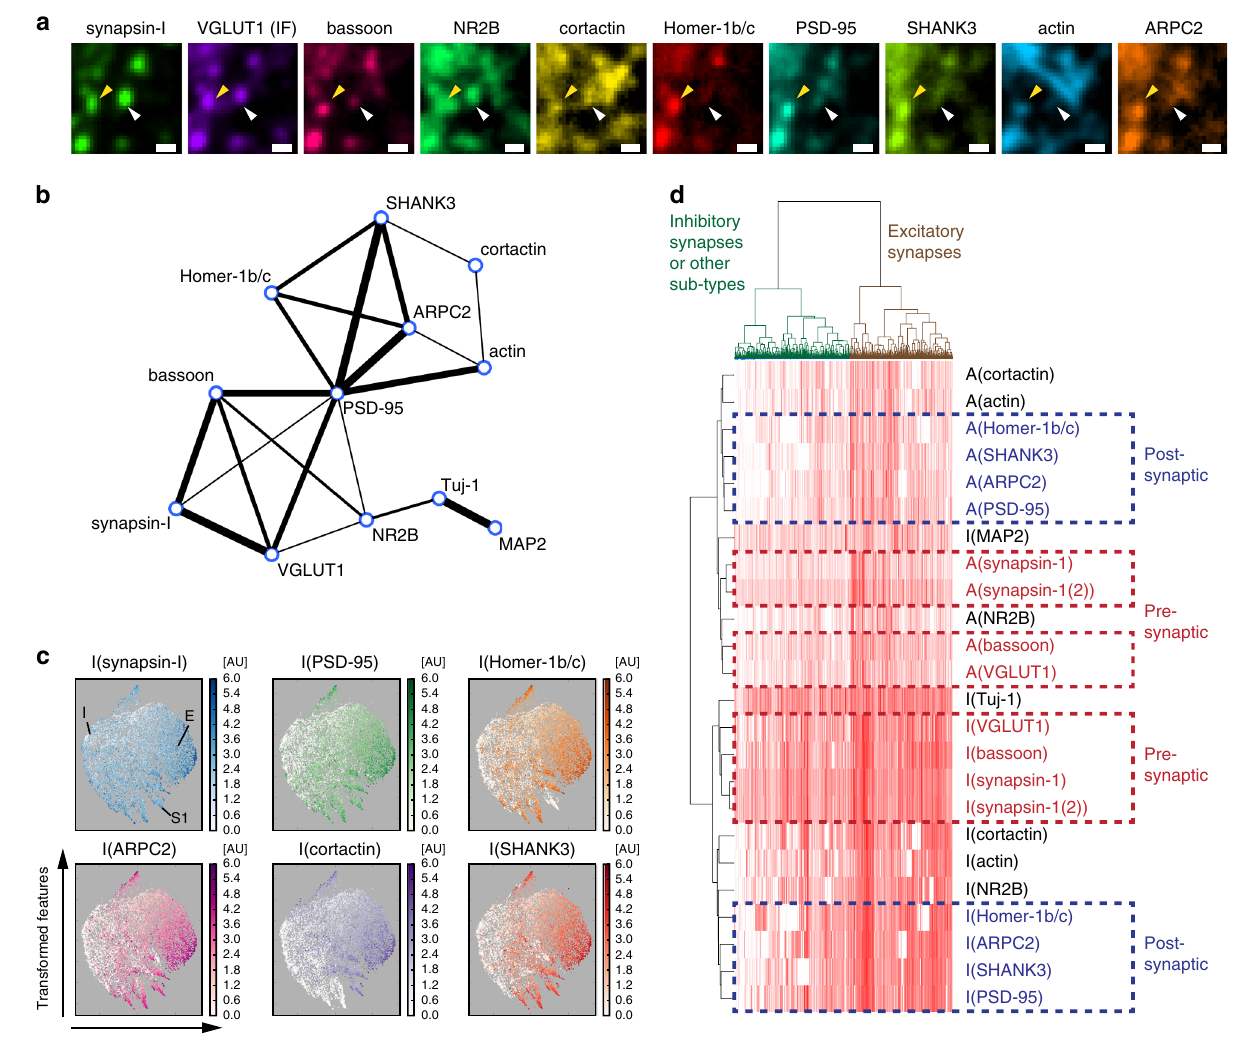
Fig. 4 Analysis of single-synapse pro fi les from confocal imaging. a LNA-PRISM images of a conventional excitatory synapse (yellow arrowhead) with co- localization of every synaptic marker measured, and a synapse with only a subset of markers present (white arrowhead). Scale bar: 1 μ m. b Network representation of correlations between intensity levels of synaptic proteins within synapses ( n = 178,528 synapses from three cell culture batches). The thickness of each edge represents the relative correlation strength between the respective nodes. c t-Distributed Stochastic Neighbor Embedding (t-SNE) plots of n = 10,000 synapses from a single culture batch; each with 20 features (intensity levels and punctae sizes of ten synaptic proteins). Each point in each t-SNE map represents a single synapse with its ( x , y ) coordinates corresponding to the transformed features that best preserve the distribution of synapses in the original high dimensional feature space. Intensity levels of individual proteins are color-coded in each map. E: cluster of conventional excitatory synapses with the presence of most synaptic markers; I: cluster of possible inhibitory synapses with the absence of most synaptic markers; S: cluster of possible sub-type synapses with the presence of only a subset of synaptic markers. d Hierarchical clustering analysis of synapse pro fi les. Each column in the heat map represents a pro fi le of a single synapse with 24 synaptic features (rows). I and A denote image intensity level and punctum size, respectively ( n = 53,698 synapses from a single culture across the synaptic cleft. NR2B exhibited correlation with both pre- and post-synaptic markers, consistent with several previous observations of both pre- and post-synaptic localizations of NMDAR 45,46 .